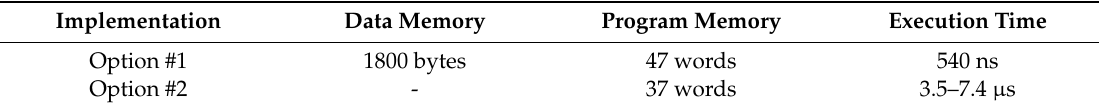
Table 12. Execution time and memory resources.